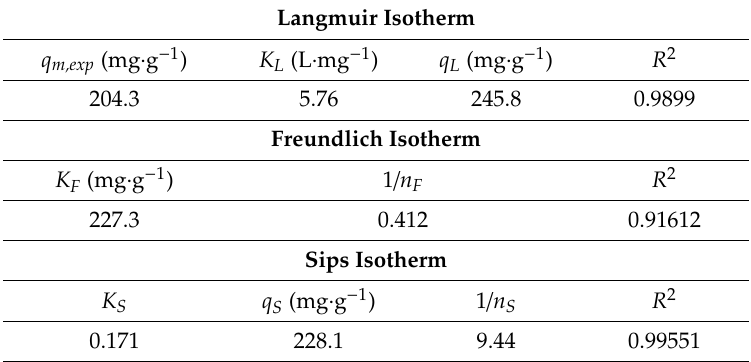
Table 2. Parameters of the Langmuir, Freundlich and Sips adsorption isotherms.